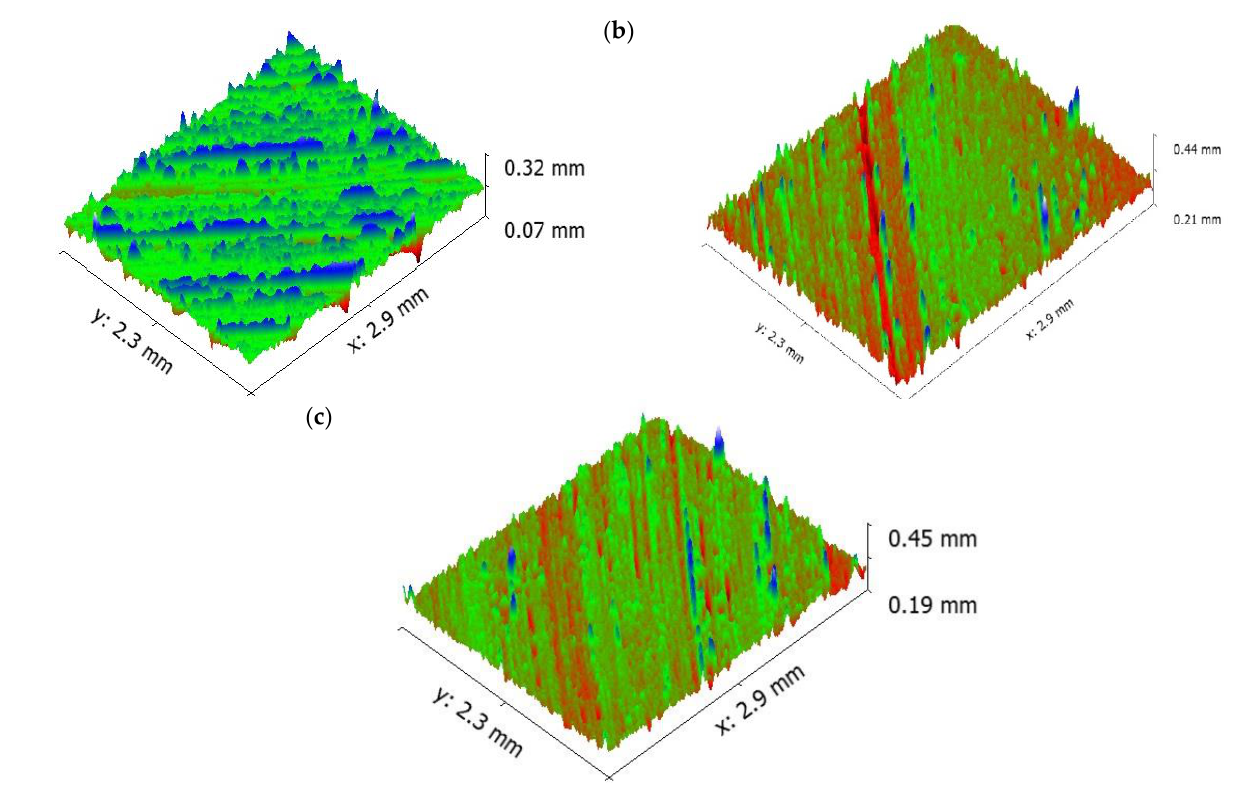
Figure 9. Worn surface topography of the pure aluminium: ( a ) 0.75 m/s ( b ) 1.5 m/s ( c ) 2.25 m/s .